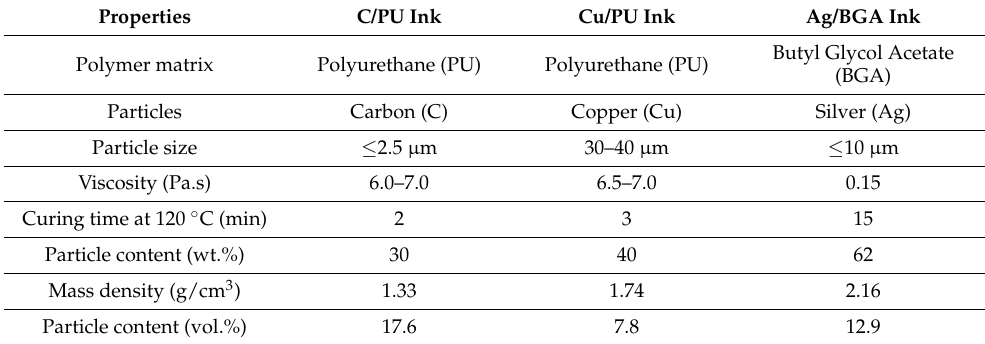
Table 1. General properties of commercially available conductive inks.